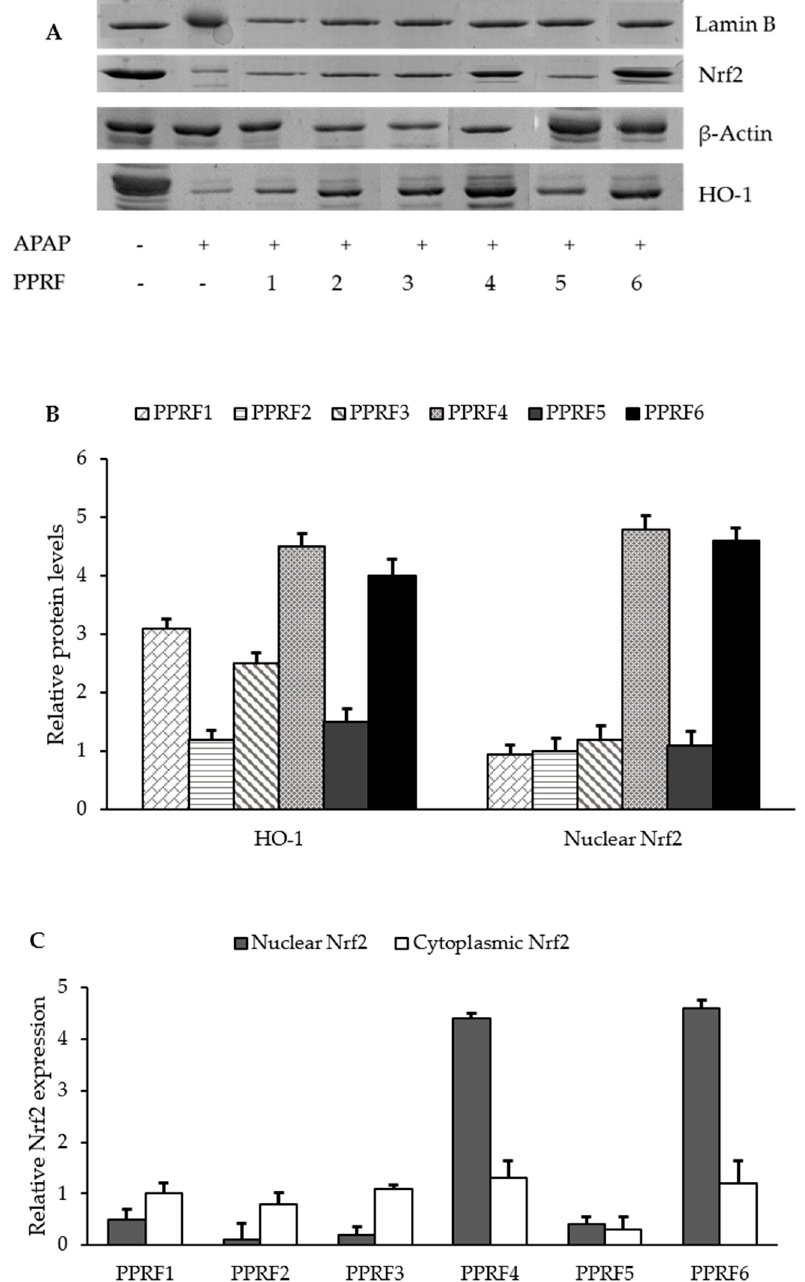
Figure 7. E ff ects of PPRFs on APAP-induced HO-1, β -Actin and, Nrf2 expression. Cells were treated with APAP (10 Mm) for 36 h and equal amounts of total proteins were subjected to sodium dodecyl sulfate–polyacrylamide gel electrophoresis. ( A ) The expressions of HO-1, β -Actin, Nrf2 protein were detected by Western blotting using corresponding antibodies. Lamin B1 and β -Actin were used as loading controls. ( B ) Relative expression of the proteins ( C ) Treatment with PPRFs for 36 h increased the Nrf2 levels in the nuclear fraction of PPRF4 and PPRF6, whereas the treatment decreased the levels in the cellular fraction. Values are the mean ± SD of three independent experiments. p < 0.05 indicates significant di ff erences compared to the control group.